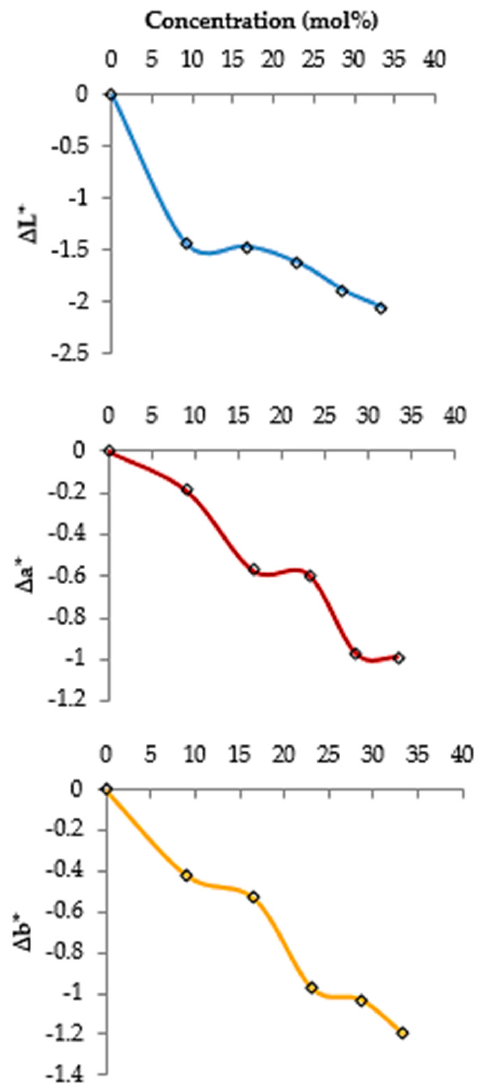
Figure 2. Effects of CO 2 concentrations on the color parameters (L* (brightness), a* (redness), and b* (yellowness)) of the dried apricots. Table 4. Means ± standard errors of the chemical properties of the control and treated dried pieces of apricot after CO 2 gas treatment at the concentration of 33.4